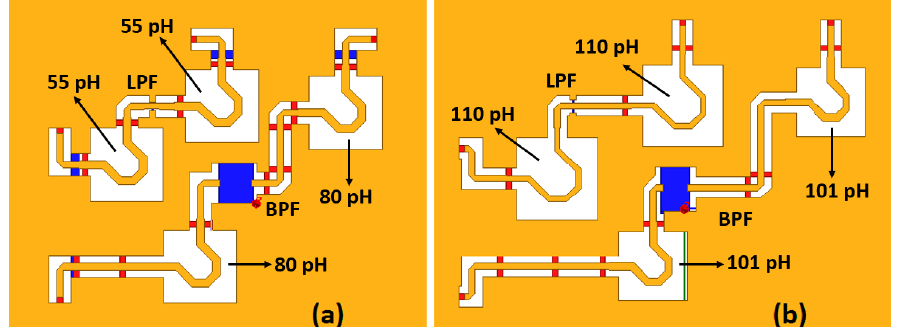
Figure 3. The passive structure of the 11.25 ( a ) and 22.5 ( b ) phase shift units simulated with HFSS.